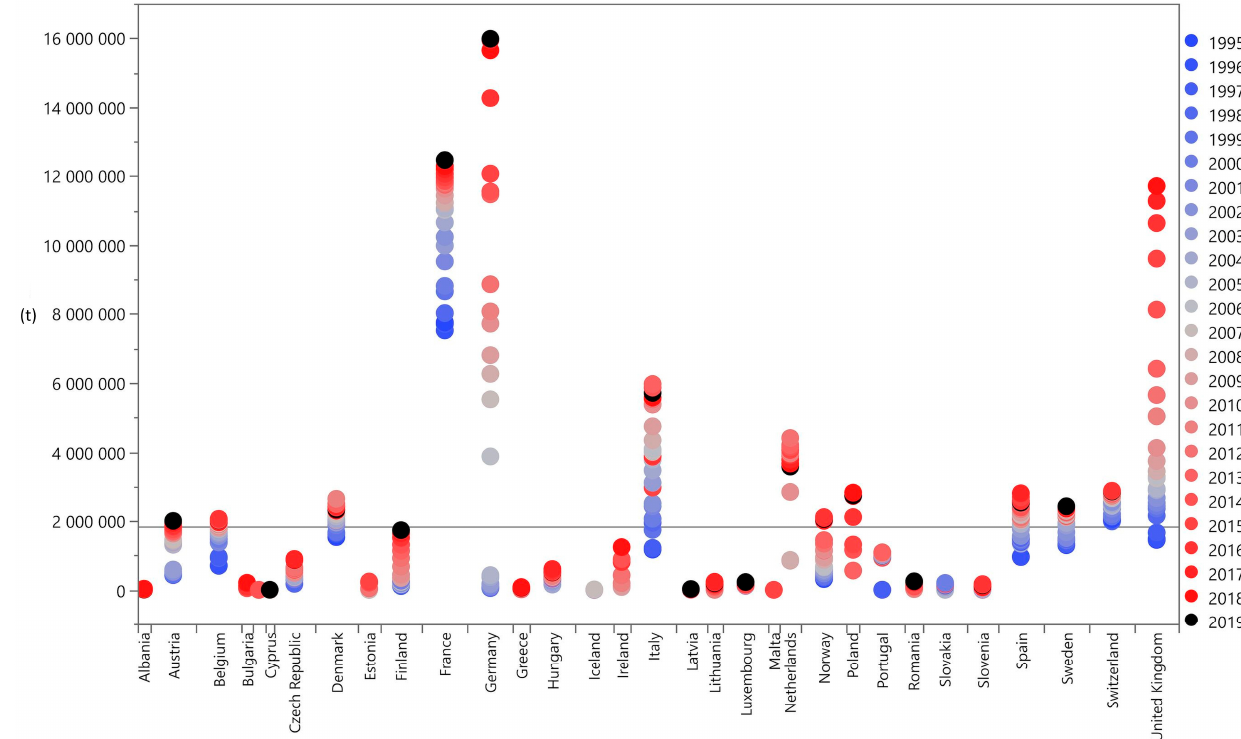
Figure 11. Composting and digestion of municipal waste in the EU for the years 1995–2019 .